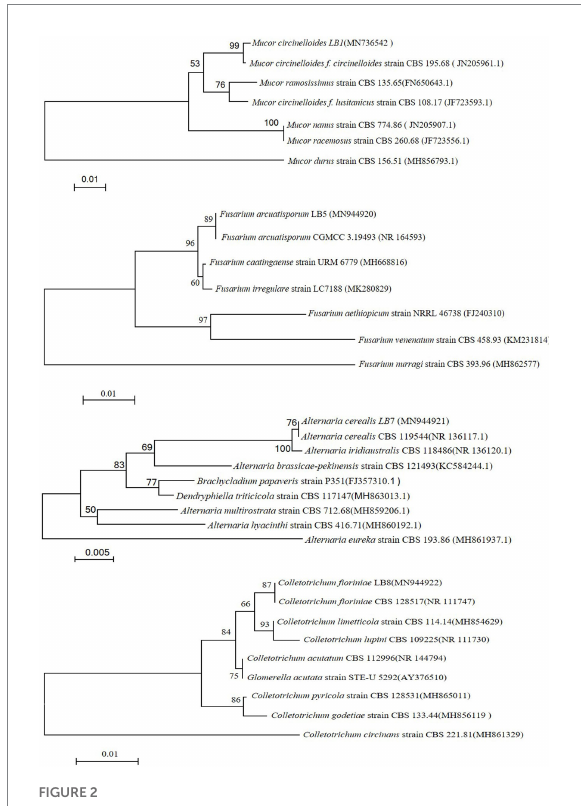
FIGURE 2 Phylogenetic tree of pathogenic fungi in wolfberry postharvest.